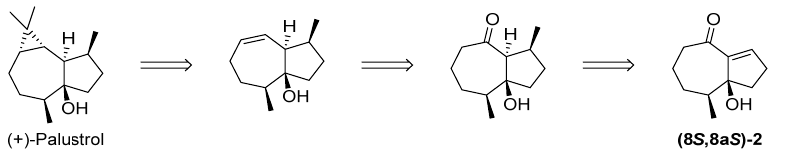
Figure 2. Stereostructures for bicyclic (8 S ,8a S )-2 and unreacted starting material ( R )-1